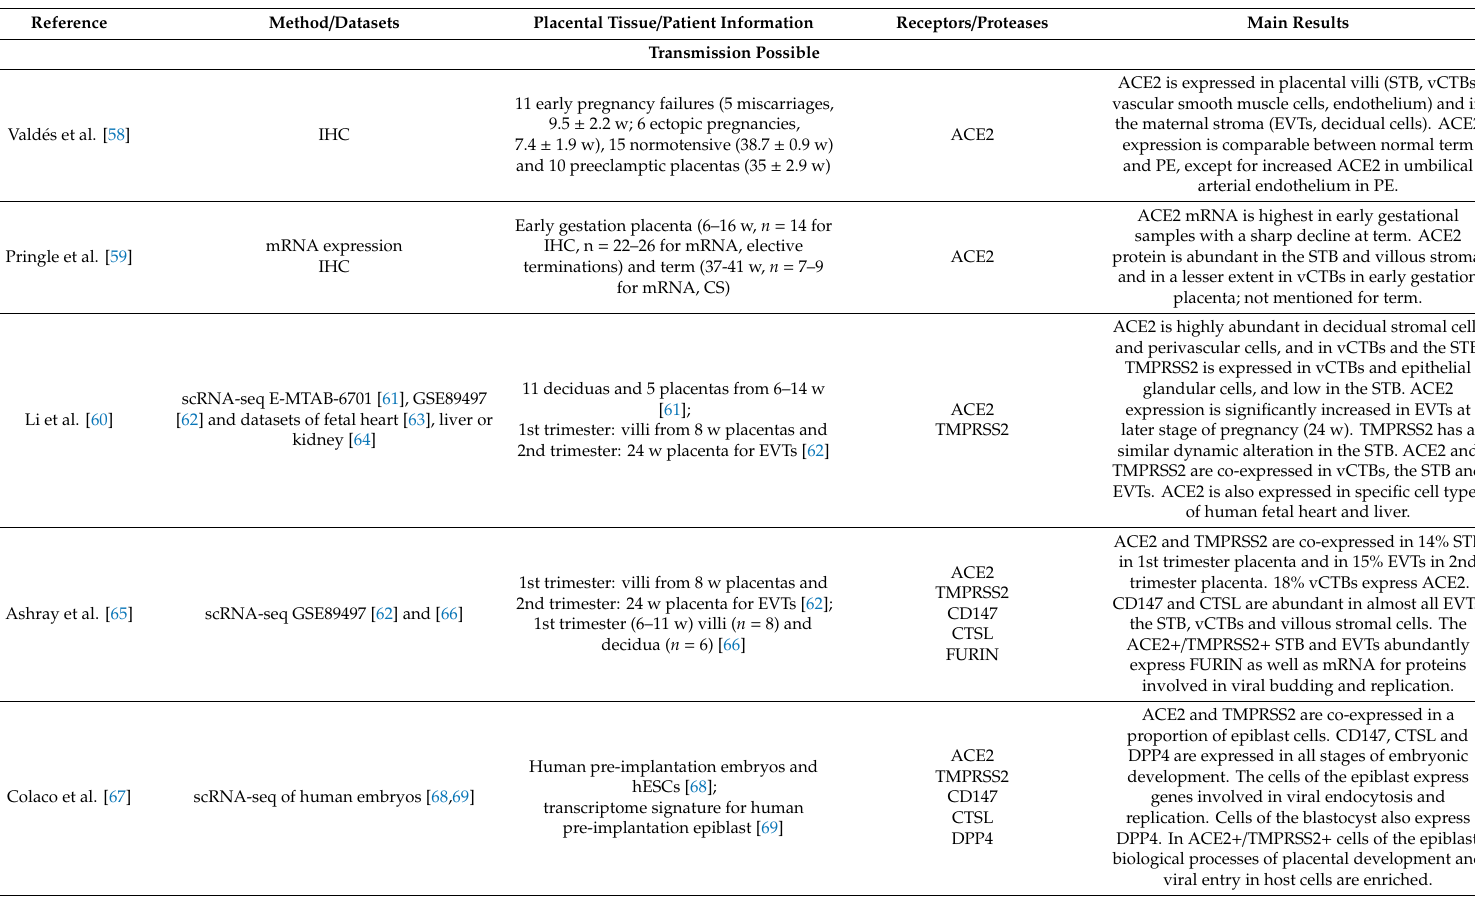
Table 1. Expression of receptors / proteases for severe acute respiratory syndrome coronavirus 2 (SARS-CoV-2) entry at the maternal-fetal interface and human embryos /